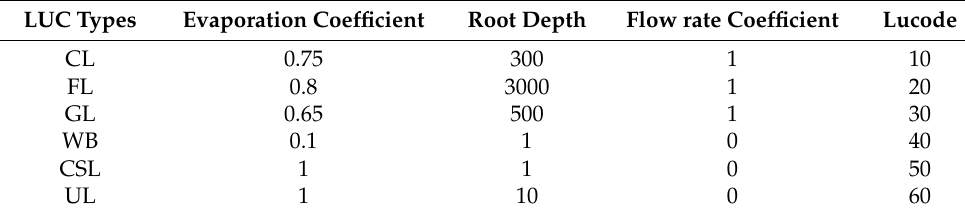
Table 6. The biophysical coefficients for different LUC